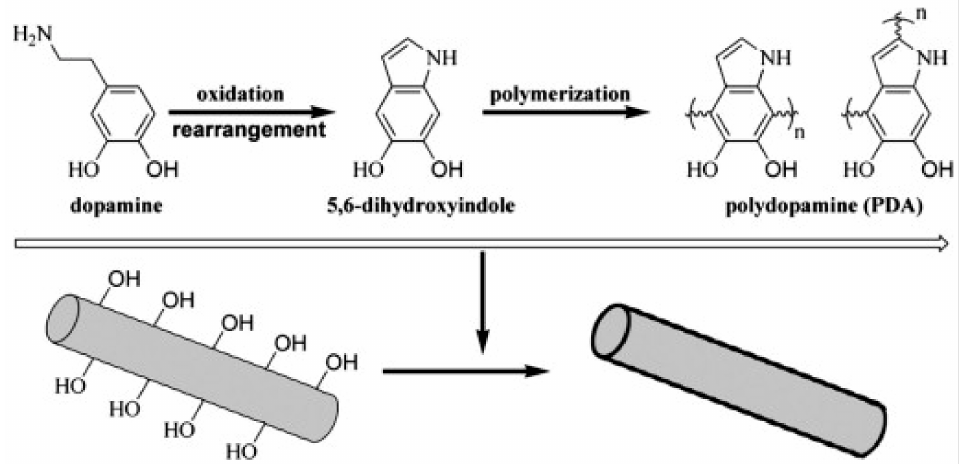
Figure 13. An illustration of the polydopamine (PDA) coating of ramie fiber. Reprinted with permission from Elsevier